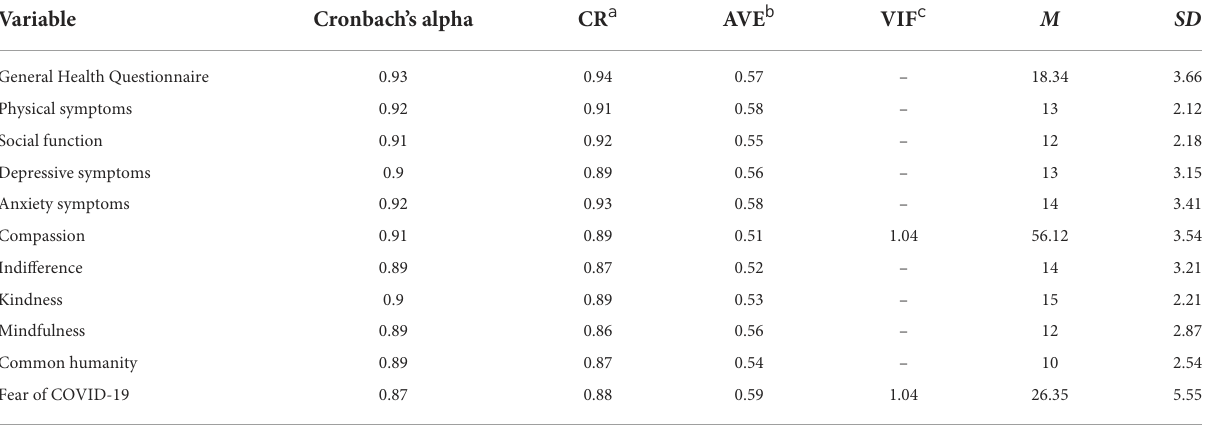
TABLE 1 Values of composite reliability, average variance extracted, variance inflation factor, mean, and standard deviation.